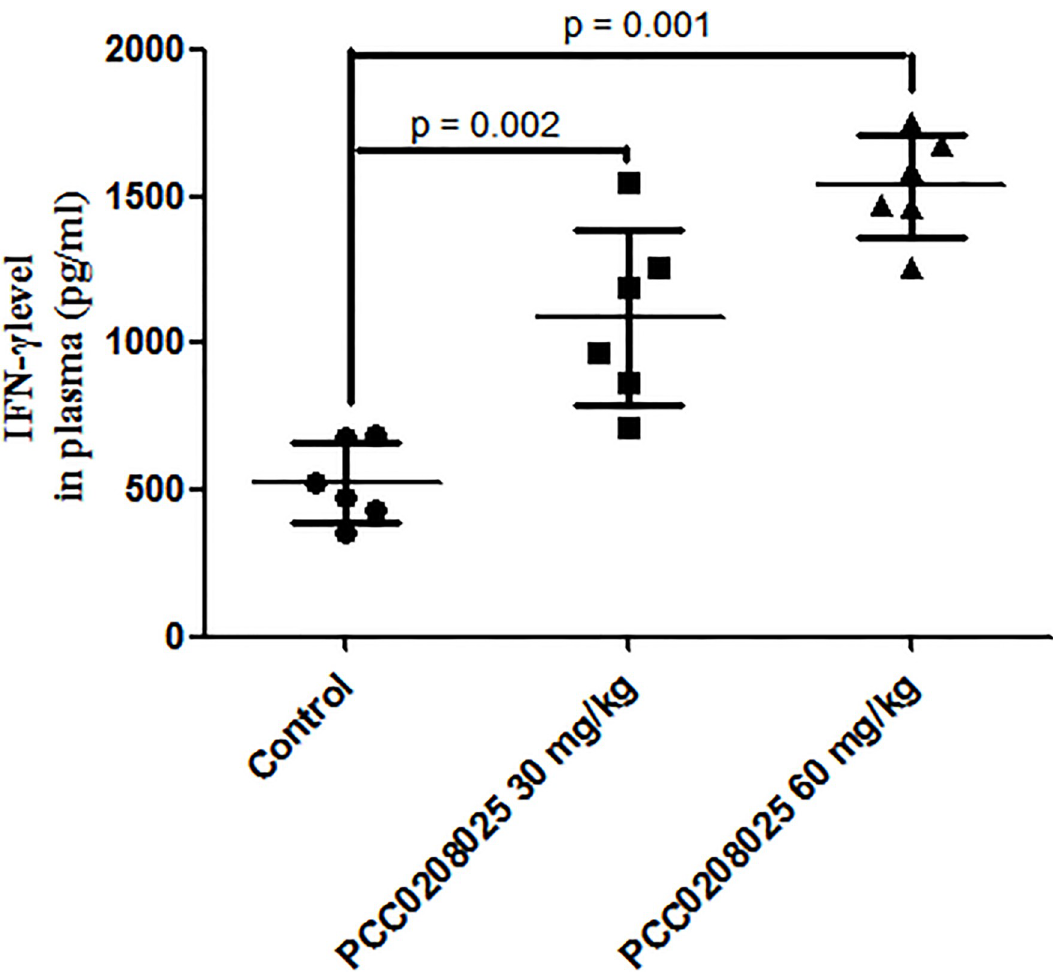
Fig 5. Effects of PCC0208025 on plasma IFN- γ level in B16-F10-bearing mice. Before all the mice with tumors were decapitated, the blood samples from orbital venous sinus were collected into tubes with heparin for plasma preparation. Plasma IFN- γ level was determined by using mice ELISA kit. The increase in plasma IFN- γ levels was observed in 30 mg/kg and 60 mg/kg groups compared with the control group (each treatment P < 0.05, respectively, n = 6). The results were presented as mean ± SD. � P < 0.05, compared with control